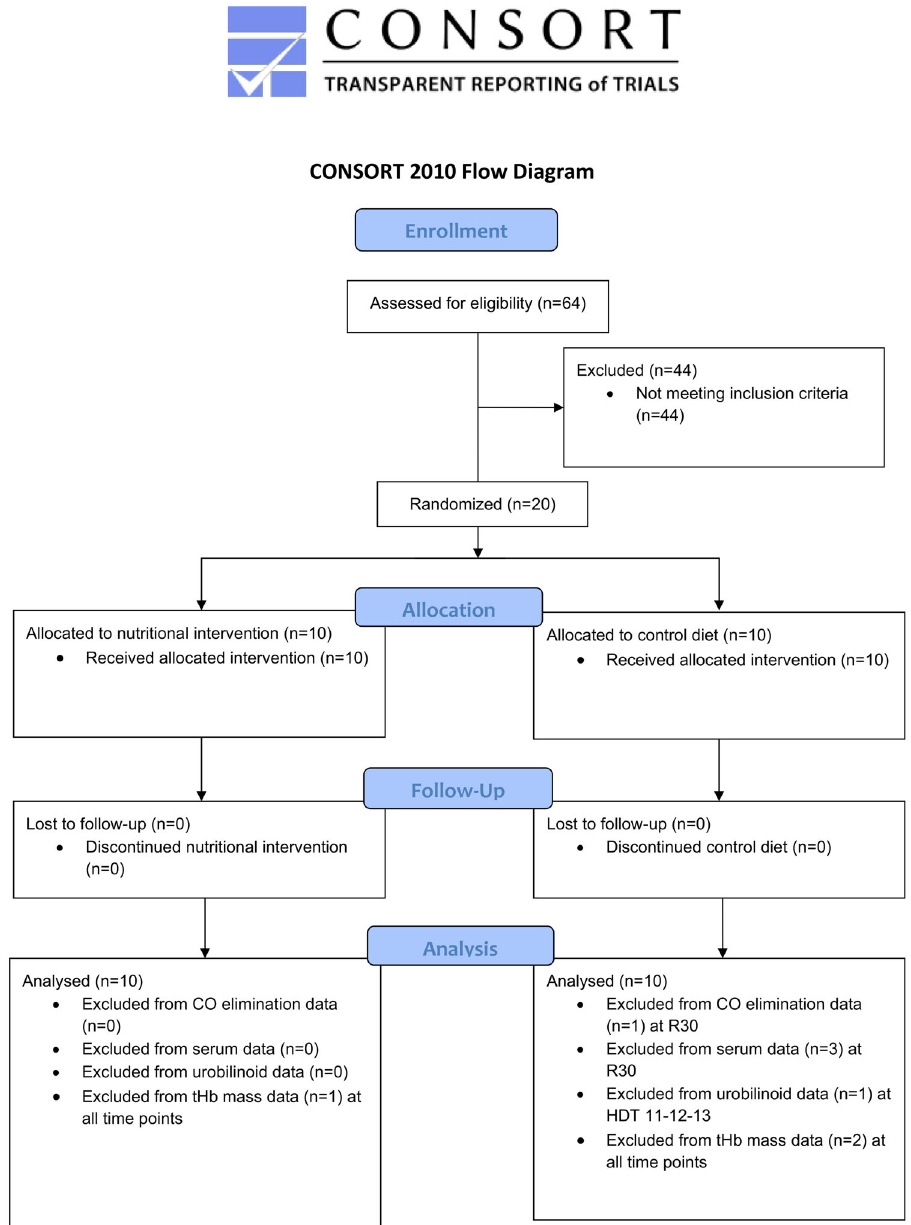
Fig. 1 CONSORT fl ow diagram for transparent reporting of trials. CO data from 1 participant at R30 was excluded due to admitted environmental factors (cigarette smoking). Blood was not drawn on three participants at reambulation Day 30. Stool samples were not collected for one participant at HDT11,12,13. Total Hb mass determination was excluded for three participants due to technical dif fi